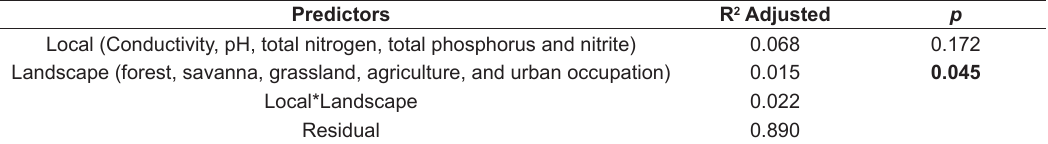
Table 2. Variance partitioning of biologic matrix explained by local and landscape predictors in the dry season. Values in bold are statistically significant: p ≤0.05.